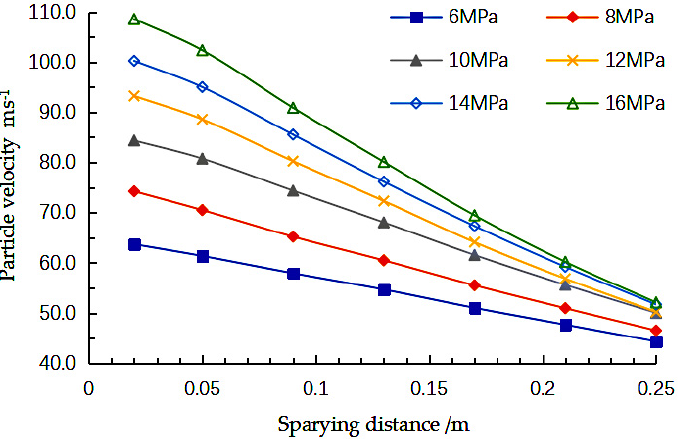
Figure 21. Variation of particle velocity with spraying distance under different pressure. Table 6. Variation rate of droplet velocity.